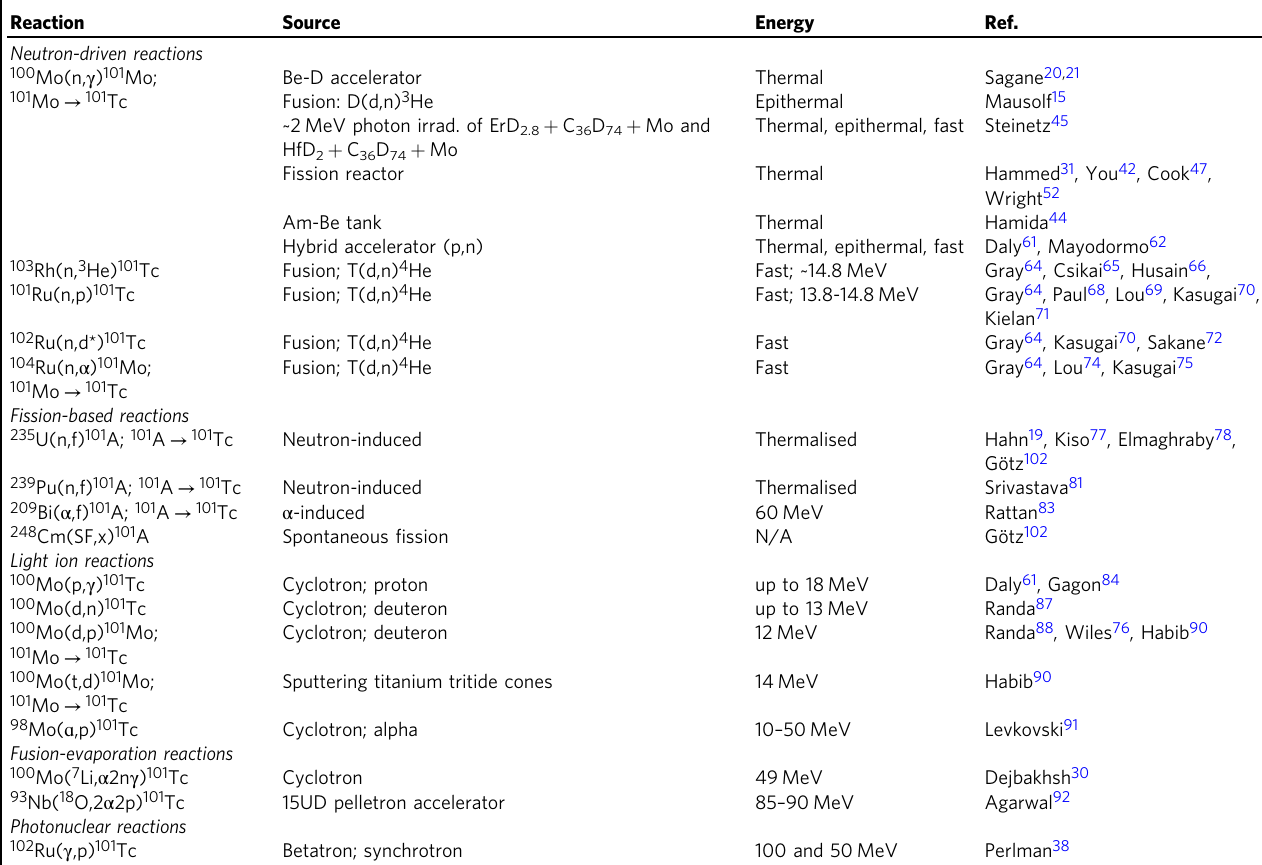
Table 3 Examples of production routes for 101 Tc.